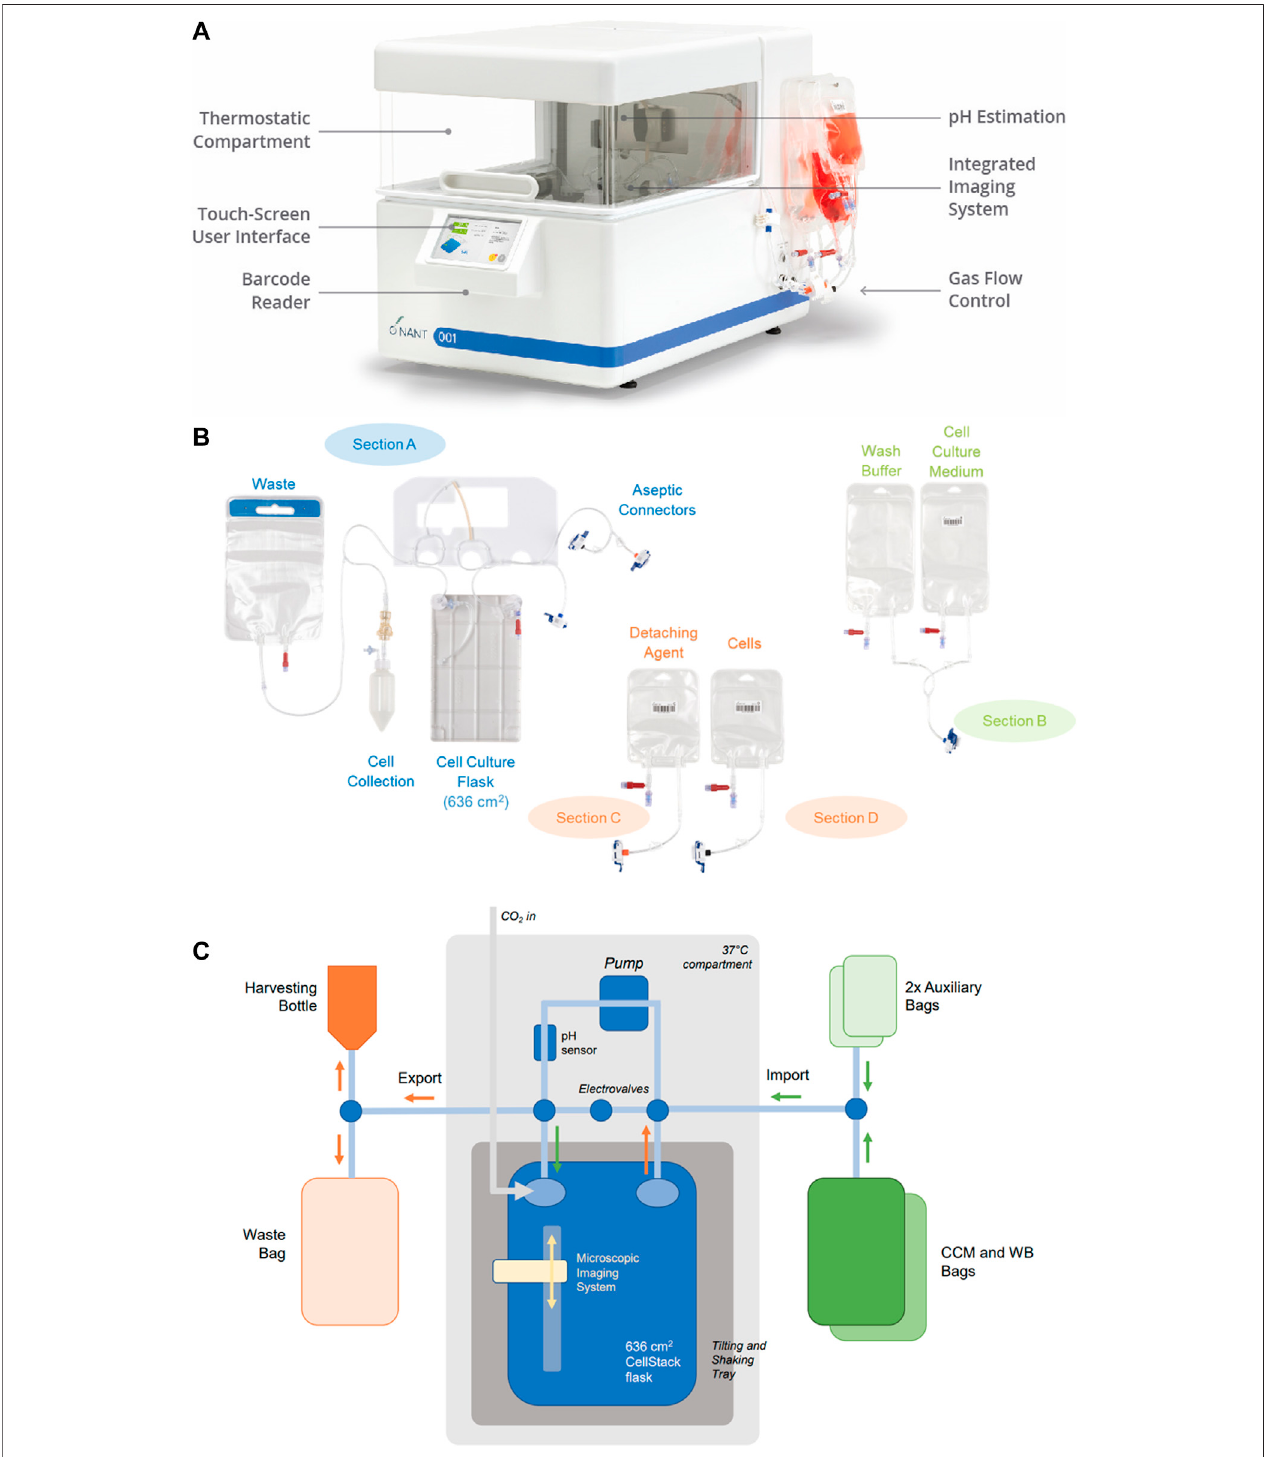
FIGURE 1 | Bioreactor design. (A) The closed, automated NANT 001 bioreactor with thermostatically controlled compartment, touch screen interface, barcode reader and with single use fl uid reservoirs attached. (B) Con fi guration of the single use components of the bioreactor, comprising of a cell culture fl ask, reservoirs for storage of media, wash buffer, cells prepared for seeding, detaching agent (typically an enzyme preparation), bag for waste fl uids and receptable for collection of the expanded cell population. (C) Fluidics design of the NANT 001 bioreactor system incorporating a sterile, single-use cell-culture chamber with a tilt and shake mechanism connected in a closed system to a series of bags containing complete culture medium, wash buffer (WB), detaching agent, cell suspension for seeding, a wastebagandaharvestingbottle.ContinuousmonitoringoftemperatureandpHisachievedbytheinclusionofsensors.Cellmorphologyandcon fl uencearemonitored using an integrated, self-operating and auto-focusing